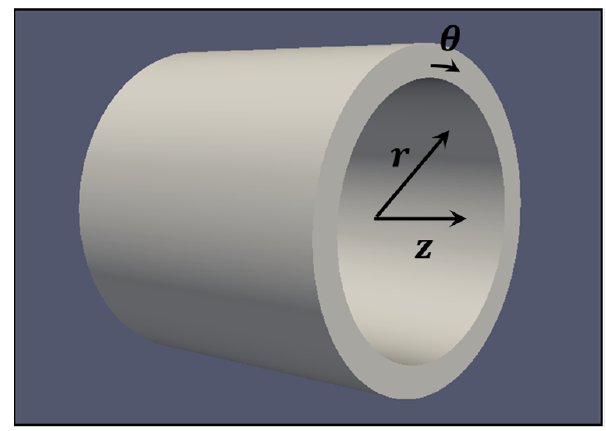
corresponds here (cid:3053)